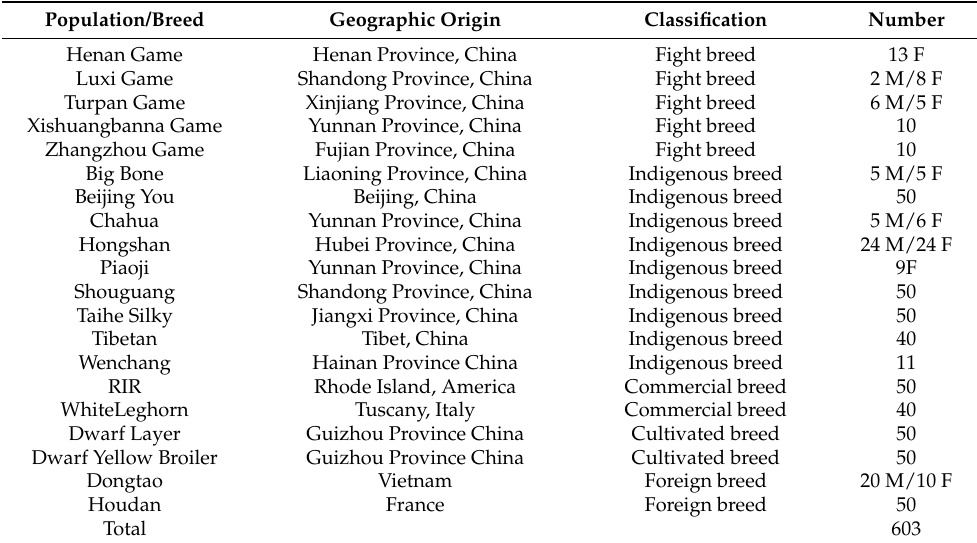
Table 1. Detailed information of the chicken samples used in our